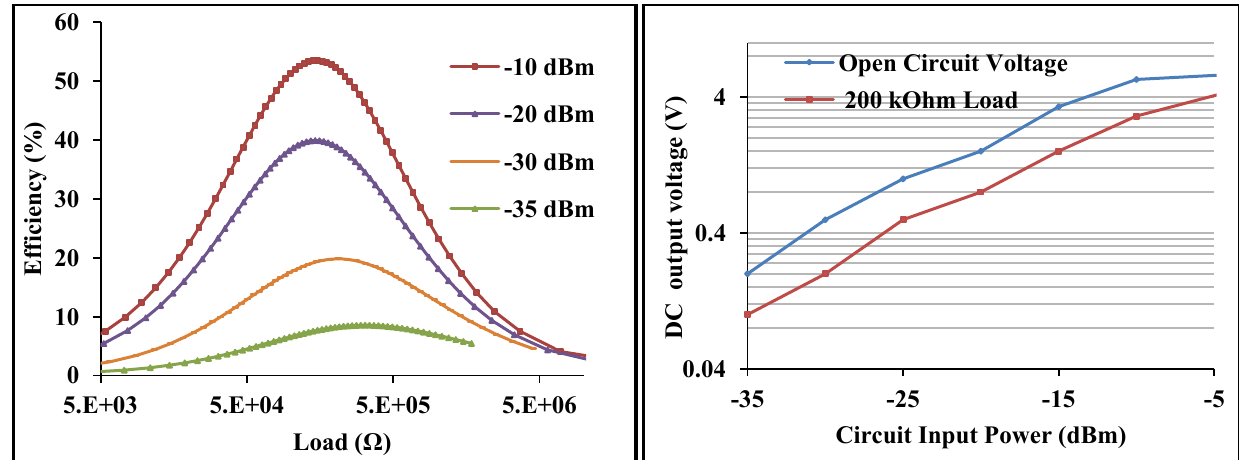
Figure 16. Measured circuit efficiency versus load at various input power levels at 13.6 MHz ( left ), measured open circuit voltage and at 200 kΩ load versus input power at 13.6 MHz ( right